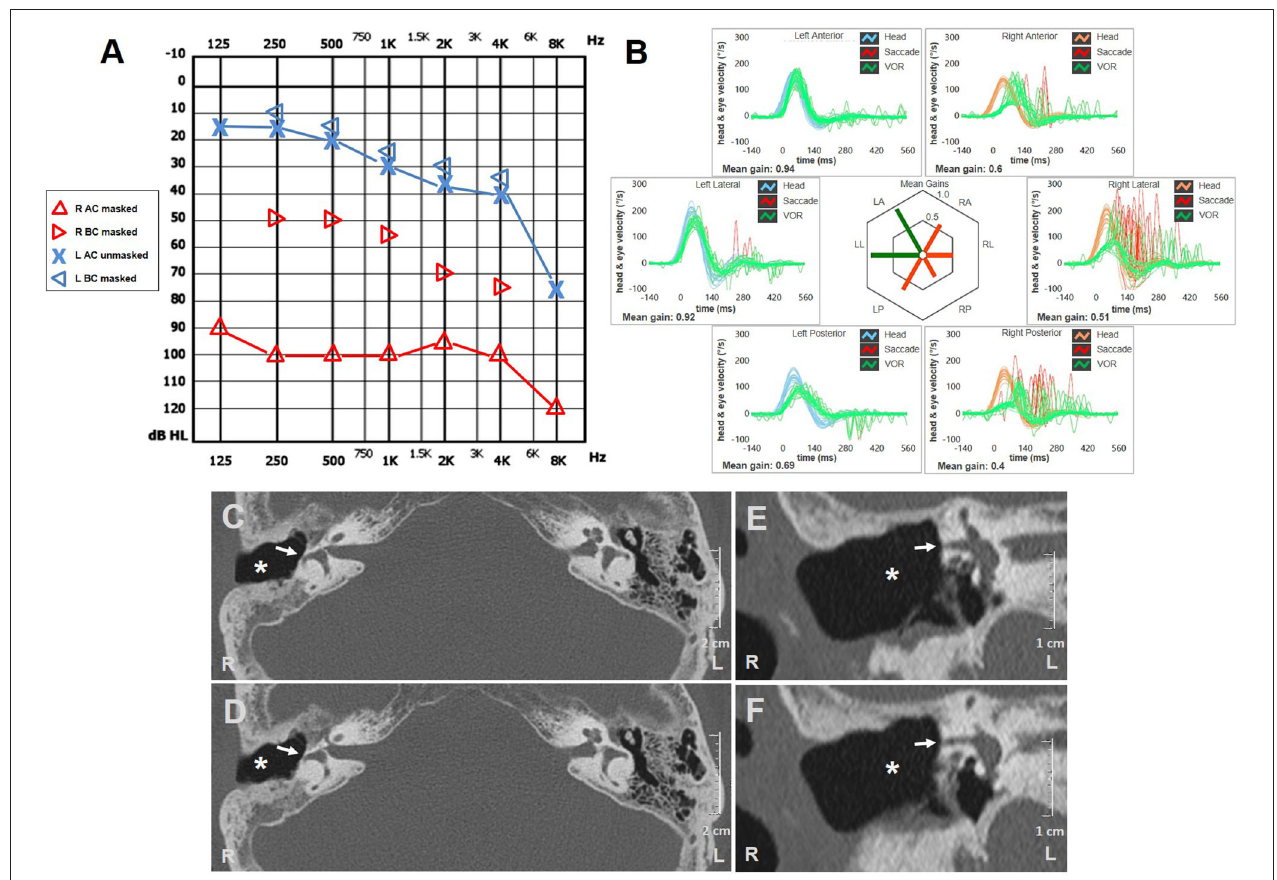
FIGURE 2 | Instrumental and radiological data of case two. (A) Audiometric test exhibiting mixed HL on the right with predominant ABG at lower frequencies and left high-frequency sensorineural HL consistent with patient’s age. (B) vHIT showing reduced VOR-gain values for all right SCs with both overt and covert saccades and slight hypoactive VOR for contralateral PSC without corrective saccades. Axial (C,D) and coronal (E,F) images of temporal bone CT scans detecting signs of previous CWD mastoidectomy ( white asterisks ) with HSC fistula ( white arrows ). ABG, air-bone gap; AC, air conduction; BC, bone conduction; CWD, canal wall down; CT, computed tomography; HL, hearing loss; HSC, horizontal semicircular canal; L, left; LA, left anterior; LL, left lateral; LP, left posterior; PSC, posterior semicircular canal; R, right; RA, right anterior; RL, right lateral; RP, right posterior; SC, semicircular canal; vHIT, video head impulse test; VOR, vestibulo-ocular